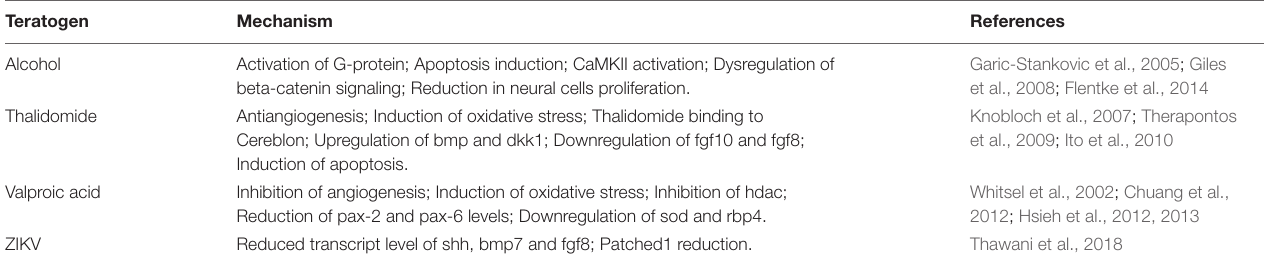
TABLE 2 | Examples of mechanisms of teratogenesis of some teratogens using chicken embryos as experimental models. Teratogen